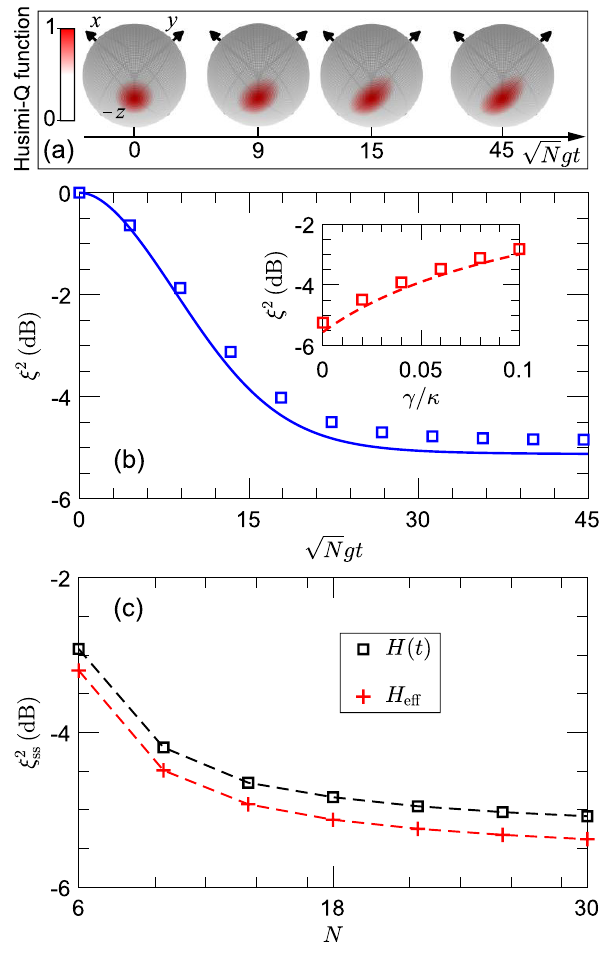
Figure 3: (a) Husimi distribution Q ( θ , ϕ ) at different times. The distribution Q ( θ , ϕ ) has been normalized to the range [0, 1]. (b) Evolution of the squeezing parameter ξ 2 . The inset shows an (cid:7)(cid:7) √ increase in ξ 2 with increasing γ / κ , at time N gt (cid:2) 45. (c) Steady- state ξ 2 versus the number N of atoms. Here, curves in (b) and crosses in (c) are predictions of H eff , while all other plots are ob- tained from H ( t ). This shows that H eff can well describe the system dynamics. In (a) and (b), we assumed that N = 18. In all plots, we assumed that g (cid:2) 0 . 5 κ , Δ c (cid:2) 200 κ , Ω (cid:2) 0 . 2 Δ c , A m (cid:2) 0 . 34 ω m , and that, except the inset in (b), γ (cid:2) 0 . 01 κ . For time evolution, all atoms are initialized in the ground state and the cavity is in the